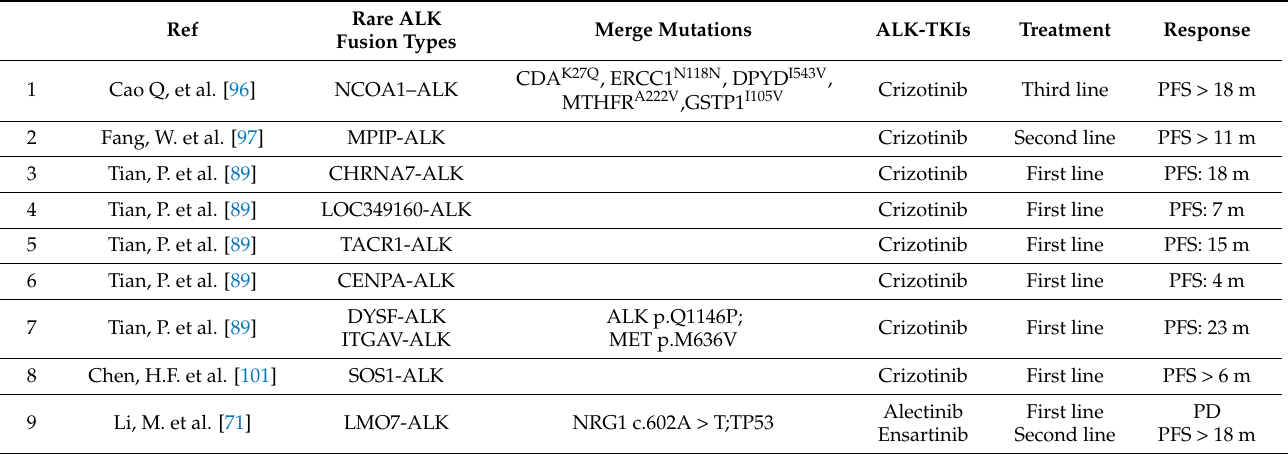
Table 4. Published details of other rare ALK fusions positive NSCLC patients treated with